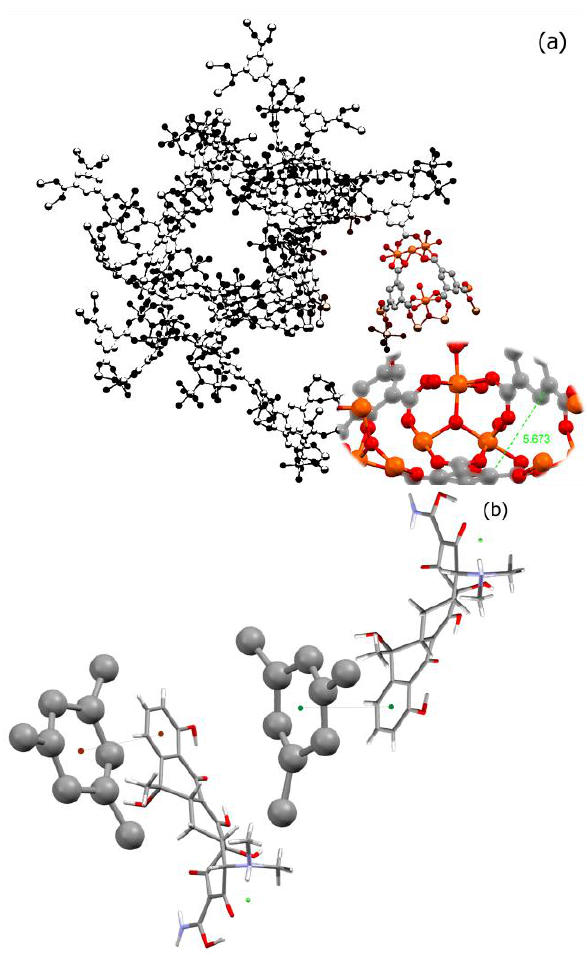
Figure 1. ( a ) The distance between two BTC rings in a pore of MIL-100; ( b ) the proposed π-π stacking between BTC rings (Ball and Stick) and TC rings (capped sticks).